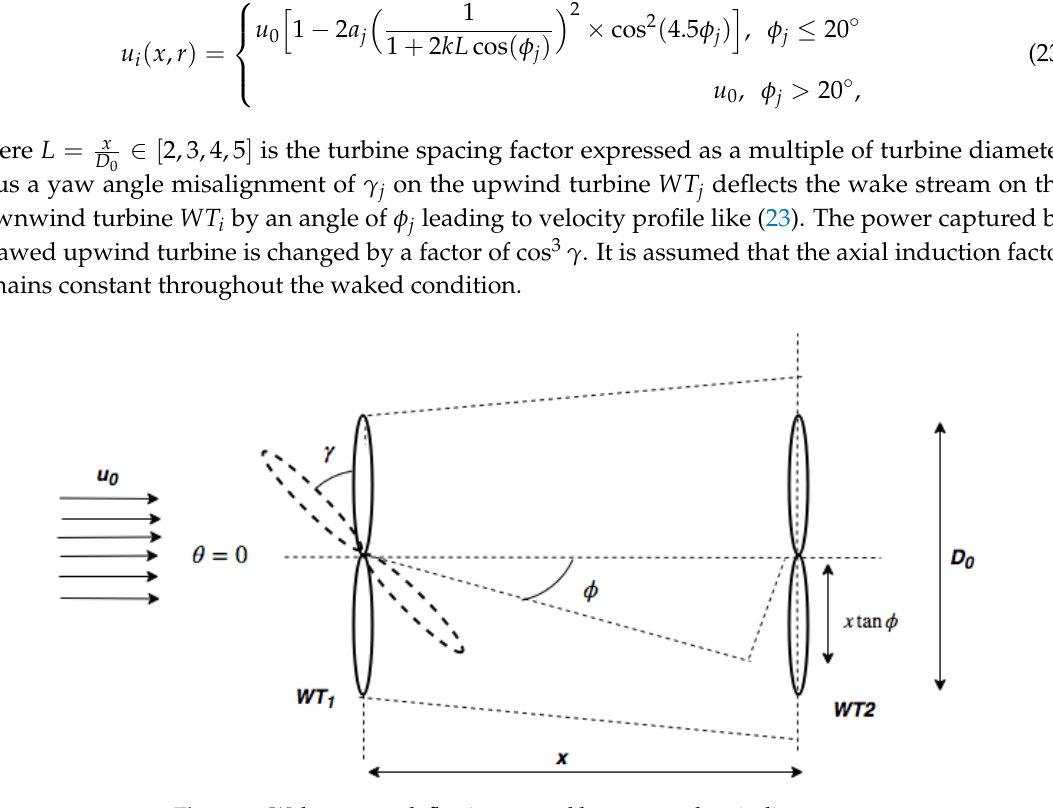
Figure 4. Wake stream deflection caused by yaw angle